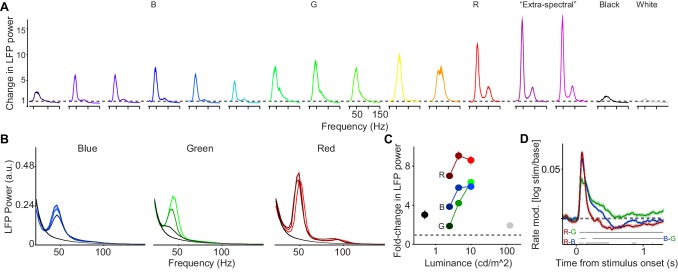
Dependence of LFP power spectra and MU firing activity on surface hue and luminance.(A) We presented uniform surfaces of 6 deg at maximum possible luminance levels, sampling from the available spectrum of wavelengths (Dataset 4, see Materials and methods; n = 5 sessions, 15.24±0.1 trials per condition in each session ). In addition, we presented black and white surfaces. Shown is the change in LFP power relative to the baseline (gray screen), expressed as a fold-change. (B) Three hues (red, green and blue) were presented at three different luminance levels (approximately 2.5, 5 and 10 cd/m2, Dataset 1, see Materials and methods; n = 5 sessions, 19.8±0.45 trials per condition in each session). Shown are LFP power spectra. LFP power spectrum estimated and normalized as in Figure 1C. (C) Average change in LFP power, expressed as a fold-change based on the fitting procedure, relative to the baseline (gray screen). The dependence of gamma amplitude on stimulus luminance was greater for G than for R or B (difference between high versus low: p<0.05, bootstrap test). Gamma oscillations amplitude R>B or G across all three luminance conditions, and B>G surface stimuli for low and intermediate luminance conditions (P<0.05, bootstrap test). (D) Modulation of firing rate relative to baseline, expressed as log10(stim/base). Horizontal bars at bottom of panel represent significant differences between stimuli at p<0.05 (permutation test, multiple comparison corrected for time bins). (B–D) Color hues were adjusted for better discriminability, panel A of Figure 4—figure supplement 2 shows actual hues.